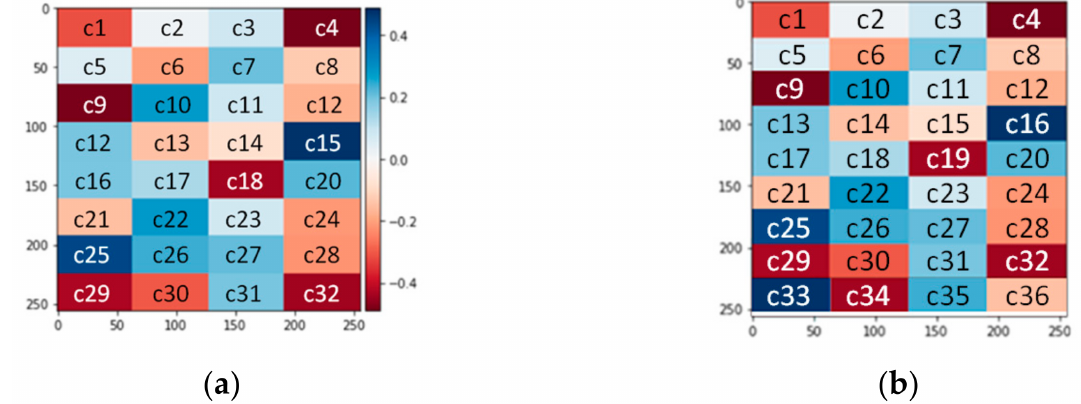
coefficients. In the output image, the pixel value of each piece is the predicted